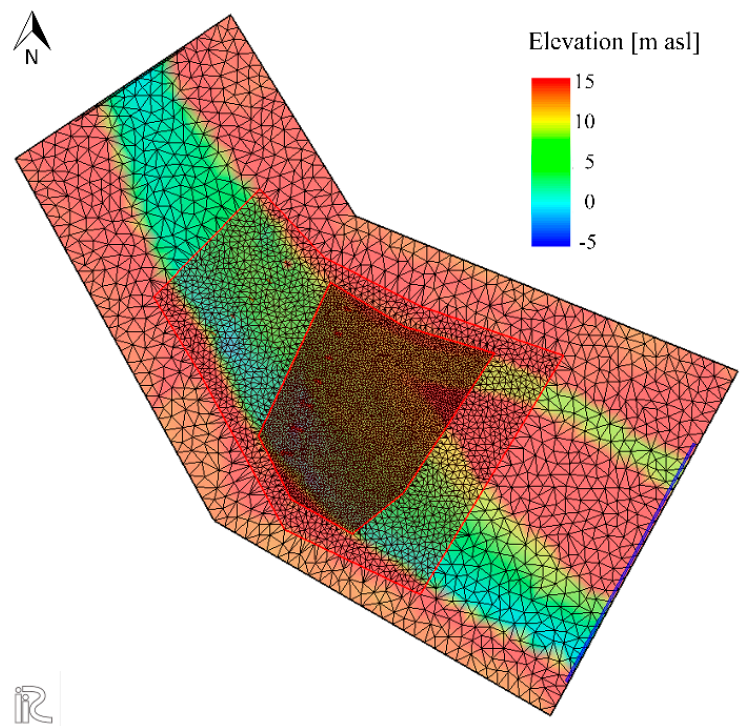
Figure 5. Nested grid structure and elevation of the bottom.